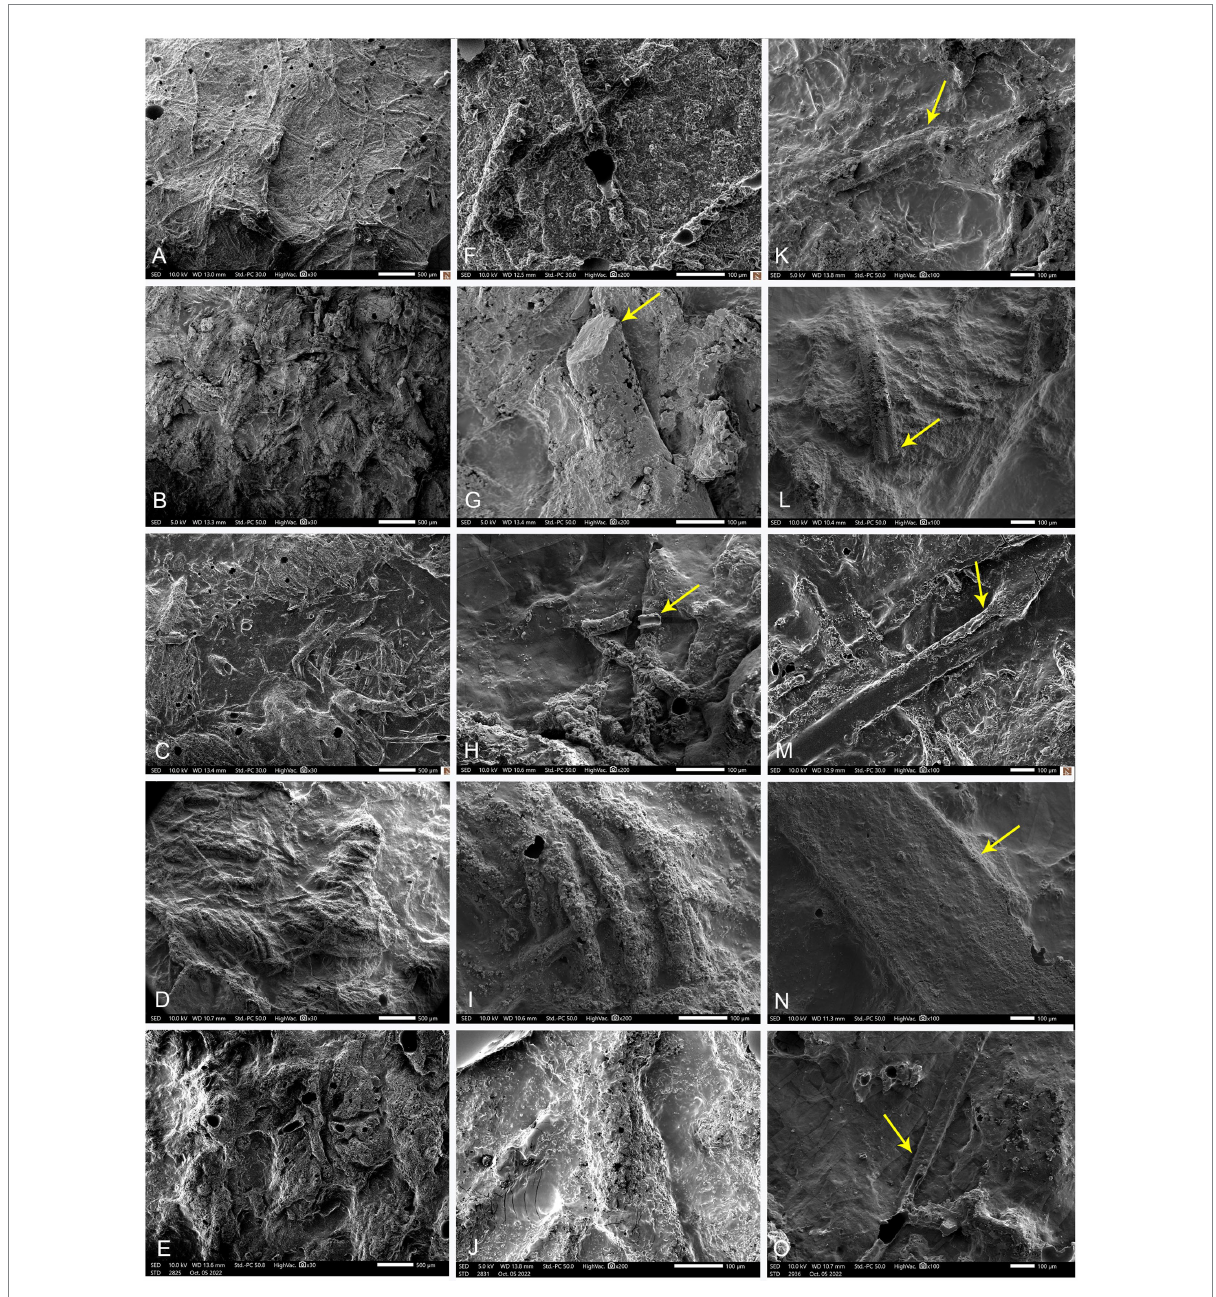
FIGURE 4 Scanning Electron Micrographs of the Chap 1 Textile Pottery. (A–E) (×30) include various examples of ‘wooly’ or ‘hairy’ textured woven textiles [ A = repp, B = repp, C = twined (?) tabby, D = repp, E = repp]. (F–J) (×200) include potential animal fibers implied. Fibers contain the diagnostic cylindrical strands, along with dimensions within the expected values (12–150 μ ) for primitive wool. (K–O) (×100) include potential plant fibers implied. Fibers contain the diagnostic flat/straight and long fibers of bast or other fibrous